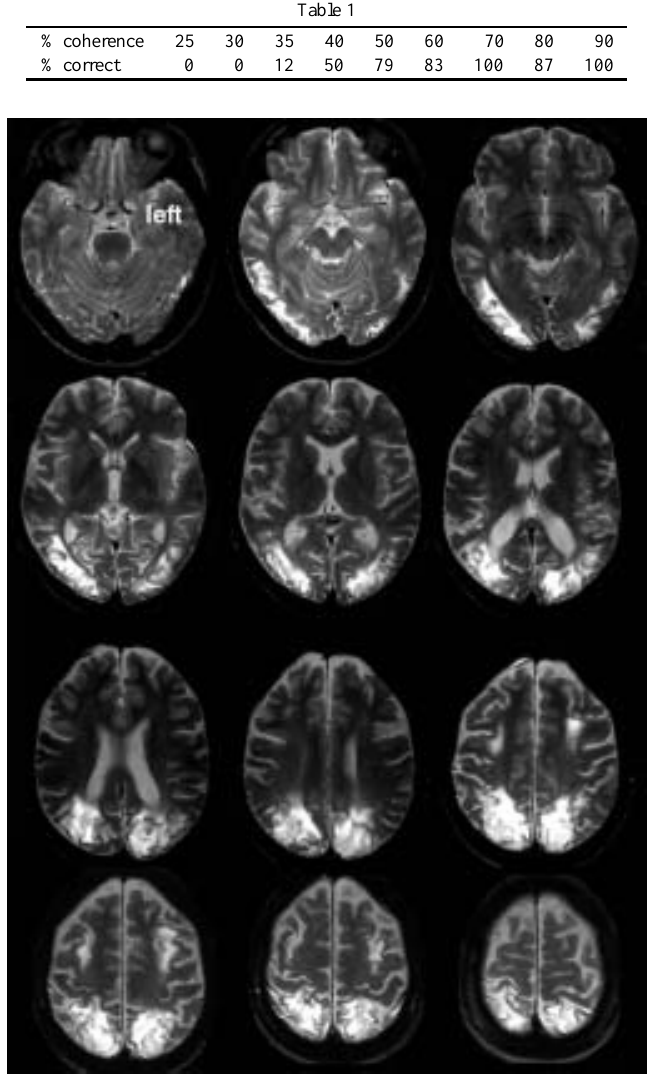
Fig. 1. The MRI horizontal sections show AT’s symmetric occipito-parietal lesions (see description in